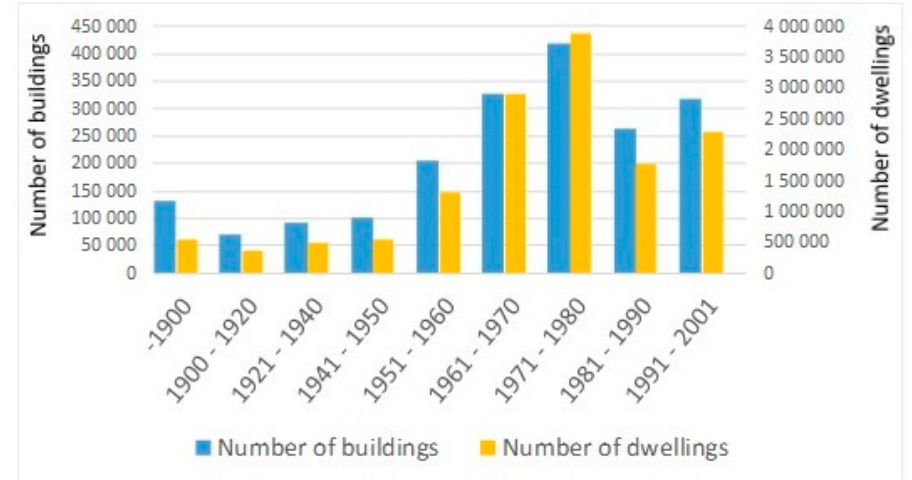
Figure 4. The Spanish apartment building stock (data retrieved from [63]).